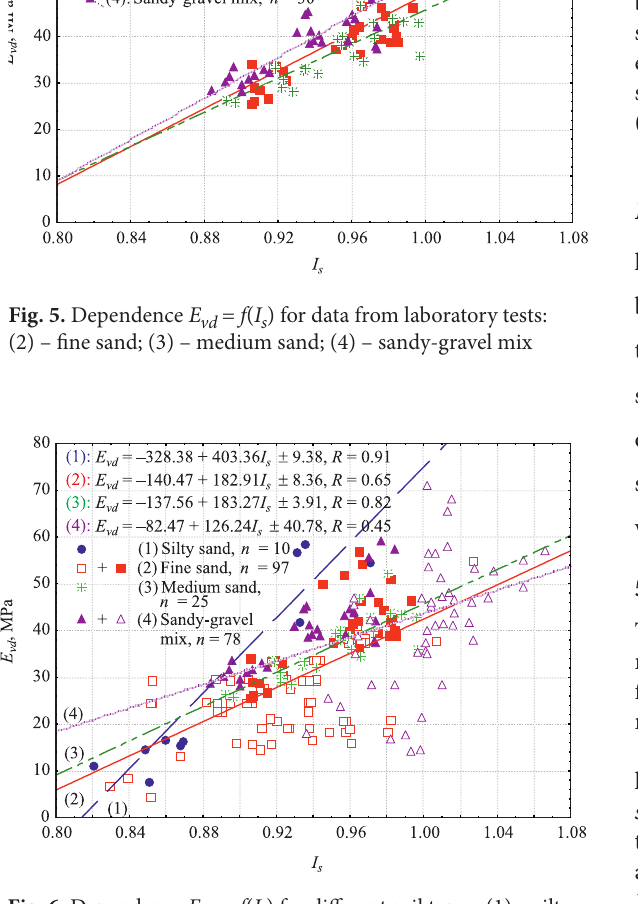
Fig. 6. Dependence E vd = f ( I s ) for different soil types: (1) – silty sand; (2) – fine sand; (3) – medium sand; (4) – sandy-gravel mix